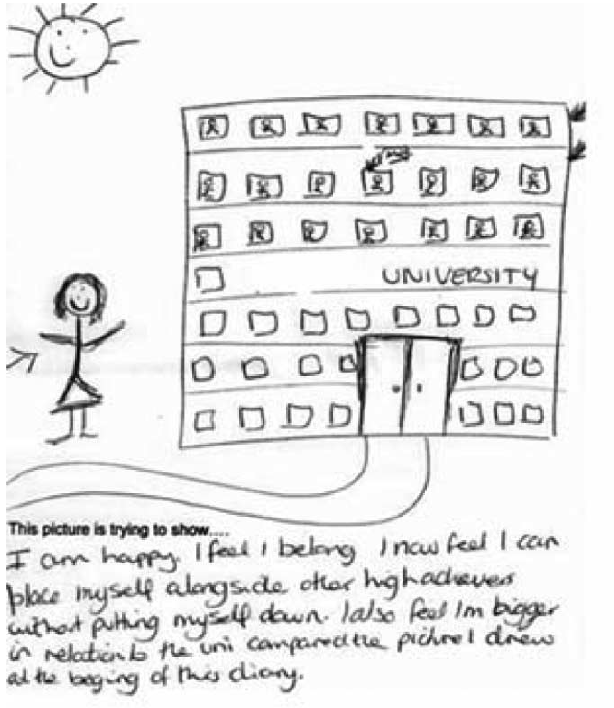
Figure 3. Image from journal